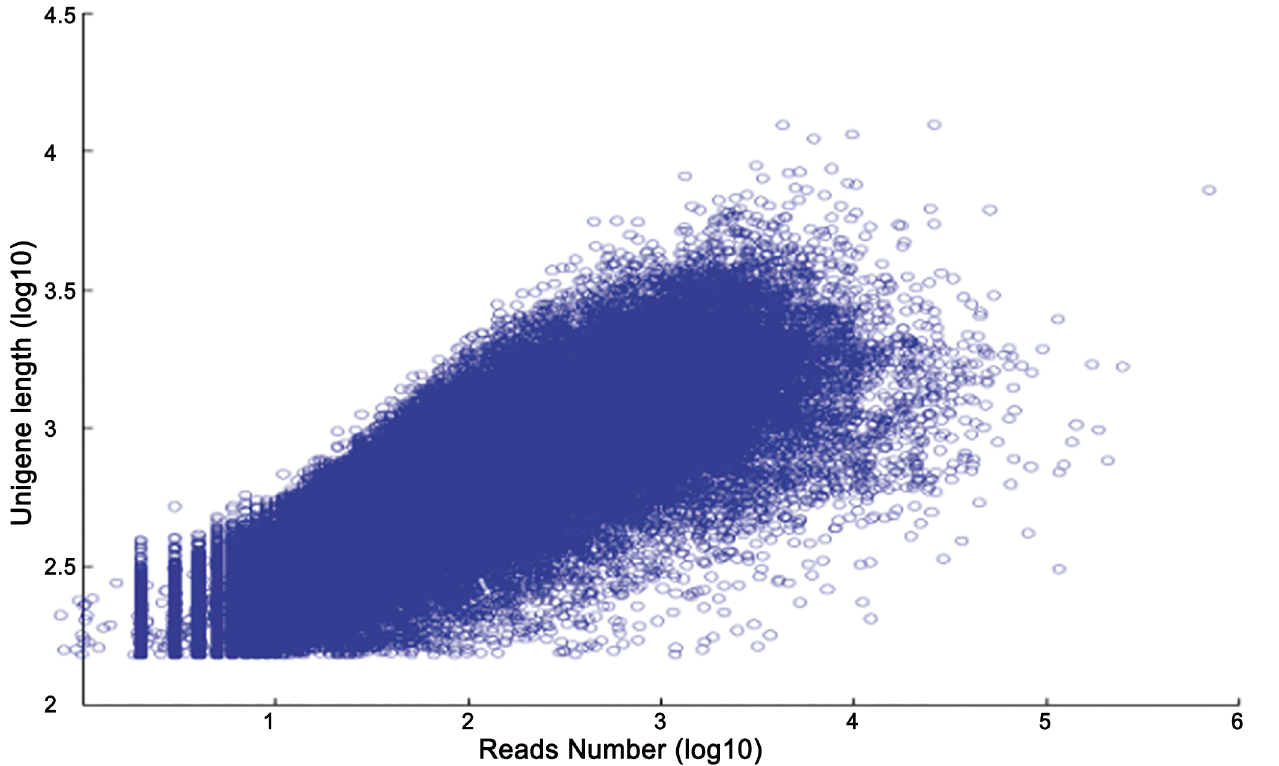
Fig 3. Plot showing the dependence of unigene length on the number of reads assembled into the corresponding unigenes. doi:10.1371/journal.pone.0154300.g003 (ORFs) were predicted using getORF software (http://emboss.sourceforge.net/apps/cvs/ emboss/apps/getorf.html), which revealed that the ORFs of 67,917 unigenes (99.33%) had an average length of 444.59 nt and an N50 of 963 nt (S3 Table and S2 Fig). These results indicated that high transcriptomic coverage was achieved for this species.